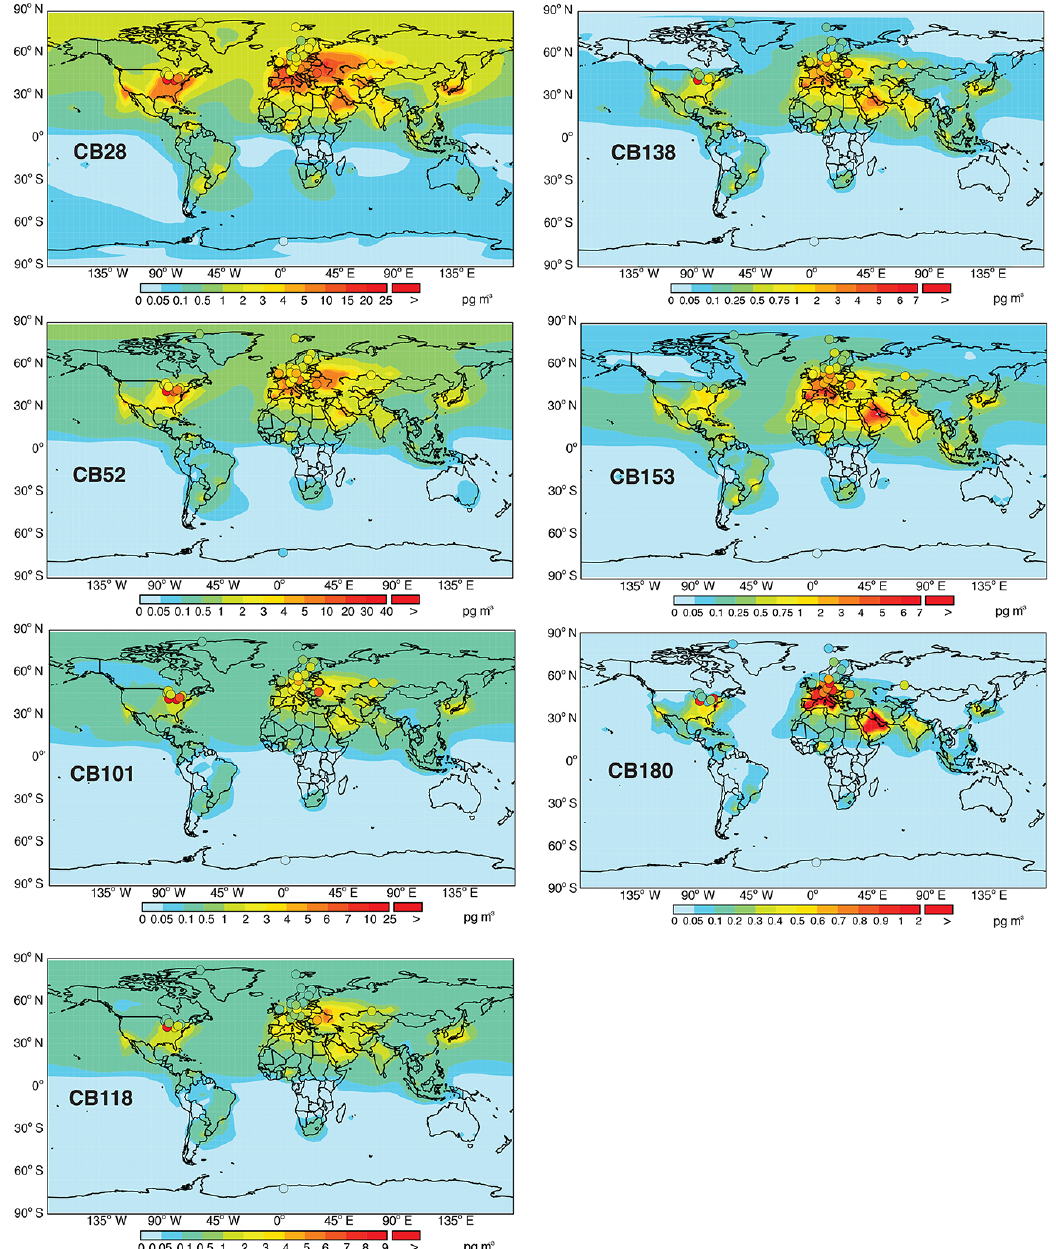
Figure 1. Average total (gas + particulate) simulated PCB concentrations in surface air from 2006 to 2010 (background) and land-based observations (circles) from measurement stations listed in Table 1. Observations are interannual means from 2006 to 2010, except in some cases where only a subset of data was